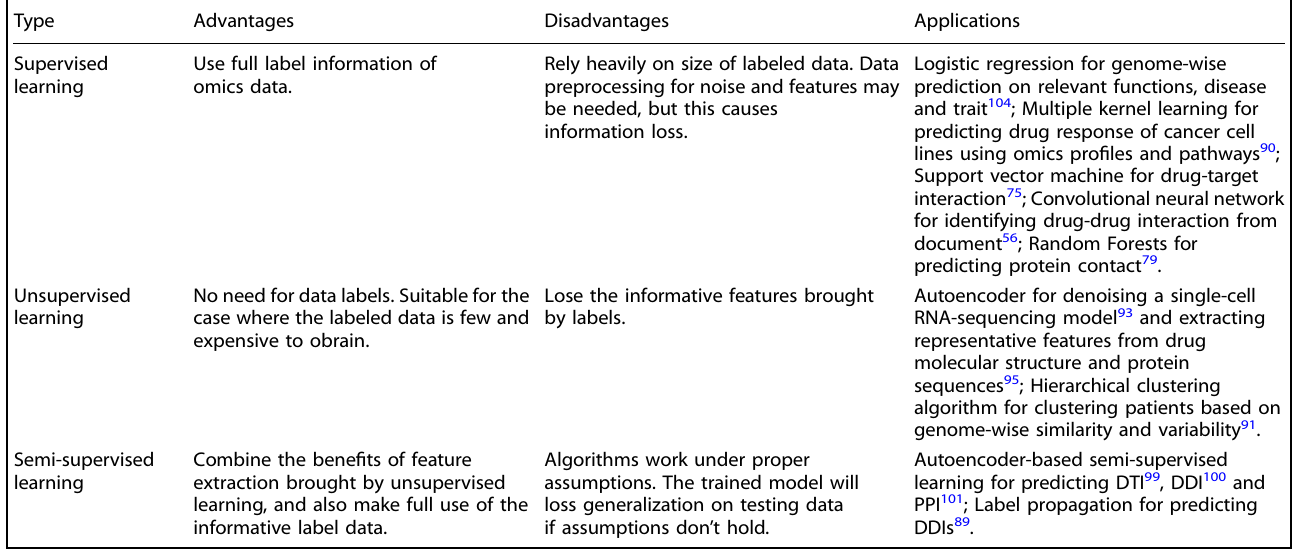
Table 3. Learning-based Methods for Predicting Molecular